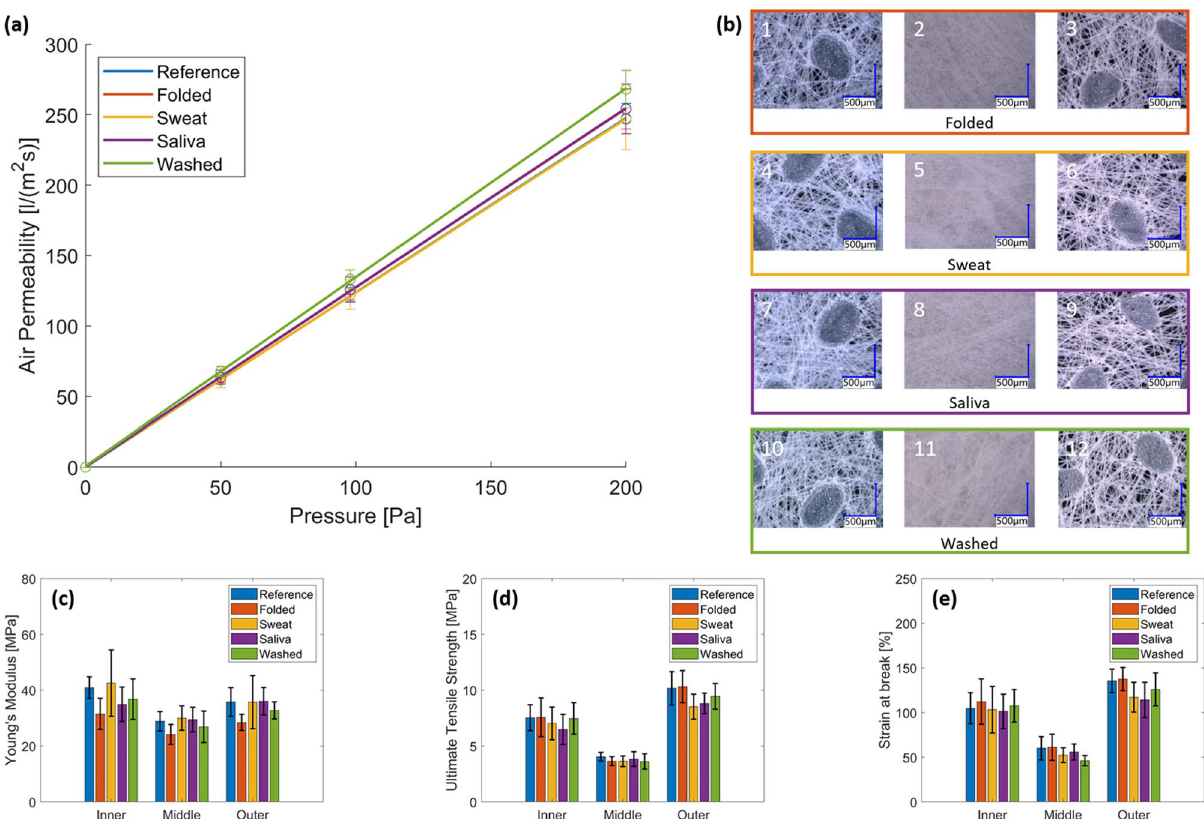
Figure 2. Characterization of the mask integrity after strong treatments: ( a ) Fitted curves of air permeability as a function of input pressure for reference and treated masks; ( b ) Micrographs of the outer (1) (4) (7) (10), middle (2) (5) (8) (11) and inner (3) (6) (9) (12) layers for the four treatment types; from mechanical testing: Young’s modulus ( c ), the ultimate tensile strength ( d ) and the strain at break ( e ) were derived for each layer of the reference (untreated) and treated